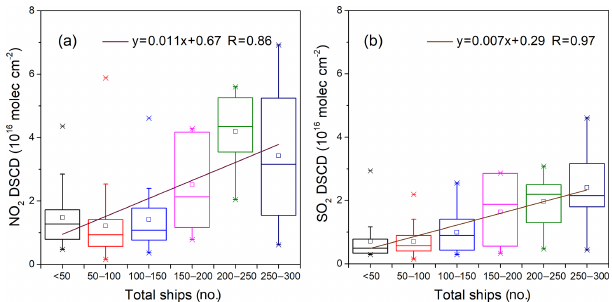
Figure 9. Relationship between the DSCDs of (a) NO 2 and (b) SO 2 at an elevation of 5 ◦ and ship density. The hollow squares in the middle of the boxes represent the mean values, and the solid lines in the middle of the boxes represent the medians. Whiskers extend from each end of the boxes to the internal and external limits. “–” represents the maximum and minimum, and the “ × ” symbols are the 1% and 99% quantiles. The upper and lower edges of the boxes are the 25% and 75% quantiles,